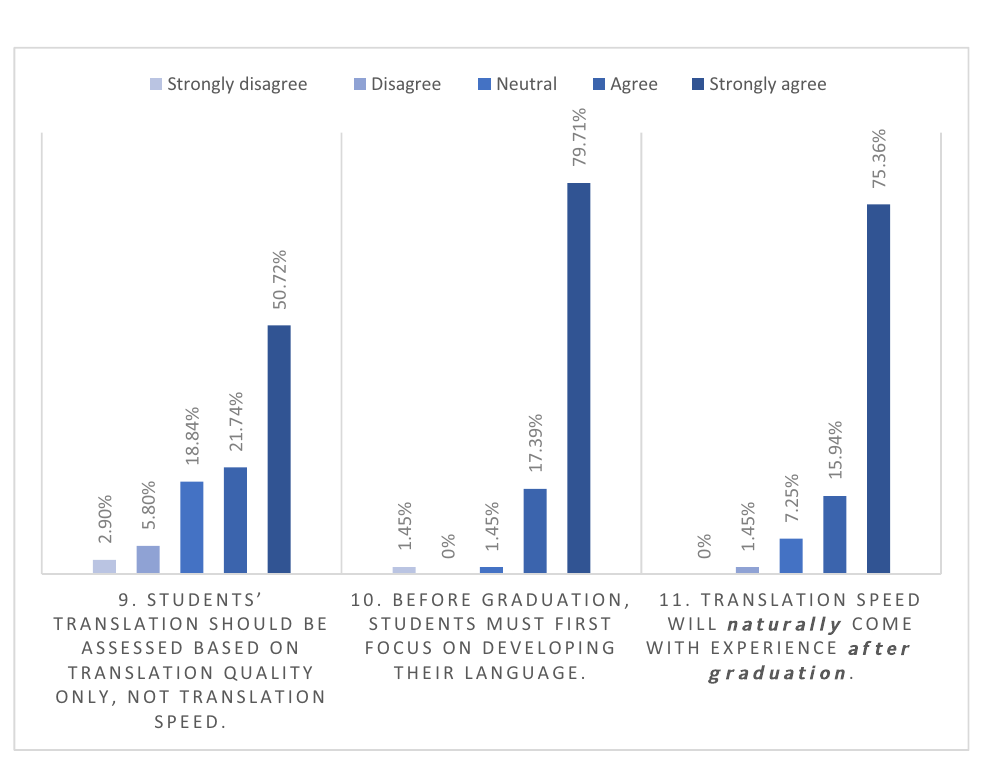
Figure 3: Speed in relation to assessment and training.